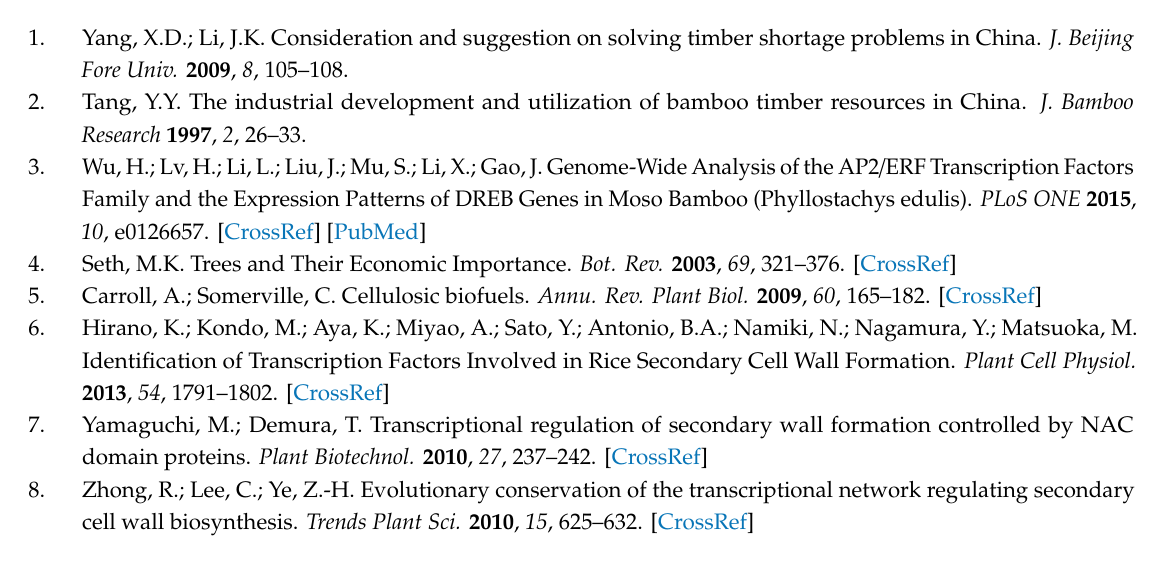
Table S1: The basic physical and chemical characteristics, and subcellular localization of proteins encoded by PeNAC s in moso bamboo, Table S2: NAC proteins from moso bamboo and Arabidopsis, Table S3: Di ff erent PeNAC s targeted by the same miRNA, Table S4: Di ff erent types of miRNAs found in the same PeNAC , Table S5: Specific primers of PeNAC s, miR164 and PeMYB s for qRT-PCR, Table S6: Specific primers of PeNAC s for transcriptional activation activity experiment, Figure S1: Expression analysis of 3 PeNAC s and miR164 in di ff erent height shoots using qRT-PCR. PeNTB was used as the reference gene. Average and error bars represented standard deviation of three biological replicates. Asterisks indicated significant di ff erence compared to the transcription level of control groups (* p < 0.05, and ** p < 0.01). 1: 1.0 m shoots; 2: 2.0 m shoots; 3: 4.0 m shoots; 4: 6.0 m shoots; 5: 8.0 m shoots, Figure S2: Phylogenetic tree based on the proteins of moso bamboo and Arabidopsis. The tree was constructed using the N-J method with 1000 bootstrap replicates as implemented in MEGA6.0. Author Contributions: X.S. and Z.G. designed the experiments; X.S. and K.Y. performed experiments; X.S., X.X. and Z.G. analyzed data; X.S., K.Y., and C.Z. contributed reagents / materials / analysis tools; X.S. and Z.G. wrote the